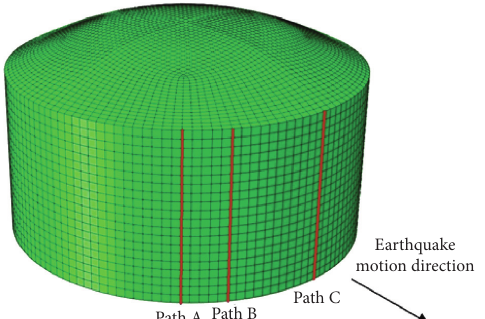
Figure 12: Three representative paths selected to analyze the von Mises stress distribution along the tank wall: A, B, and C.